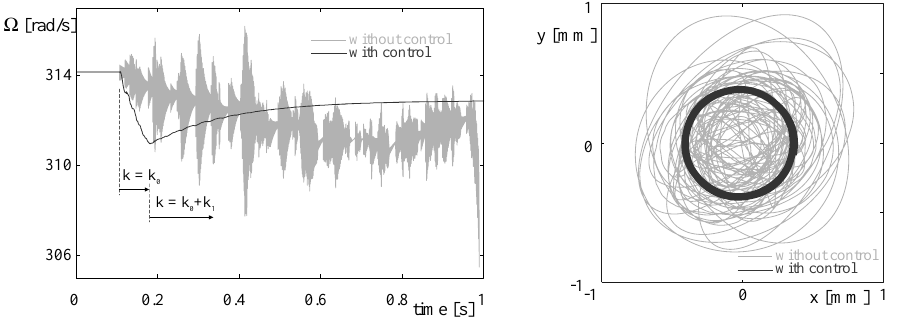
Fig. 13. Rotatory speed (left), rotor orbit (right).